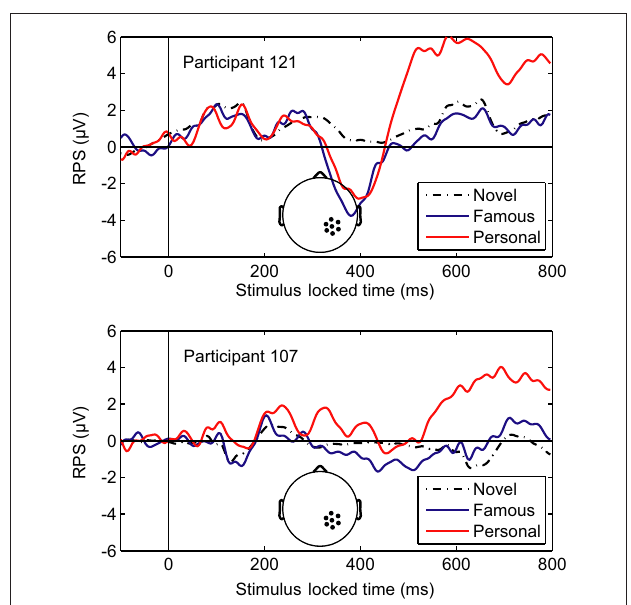
Figure 5 | Averaged-referenced erPs for two individual participants. Top panel: ERP for participant 121 with high AUC (0.91). Bottom panel: ERP for participant 107 with low AUC (0.69). The AUC values were calculated using the general classifier model. Inset: the RPS channel group.